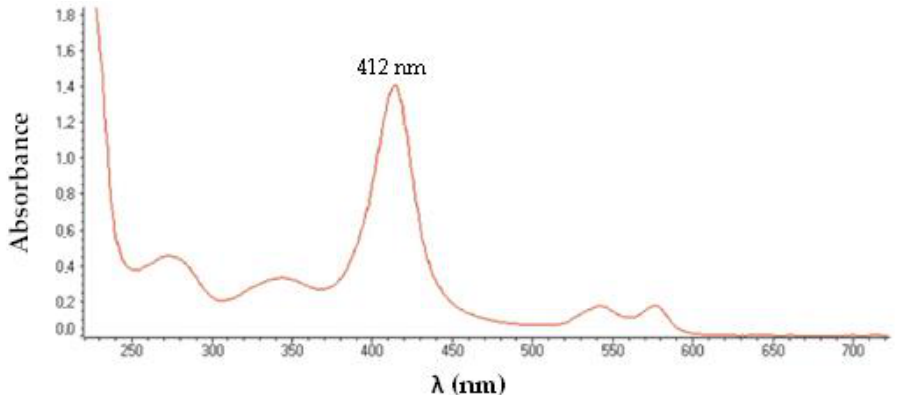
Figure 6. Standard UV-Visible absorbance spectrum (a.u.) of RBCs diluted in distilled water, in the 230 –720 nm wavelength (λ, nm) range of the optical spectrum. The maximum absorbance value was registered at 412 nm. Adapted from [26], under the terms of the Creative Commons Attribution License.